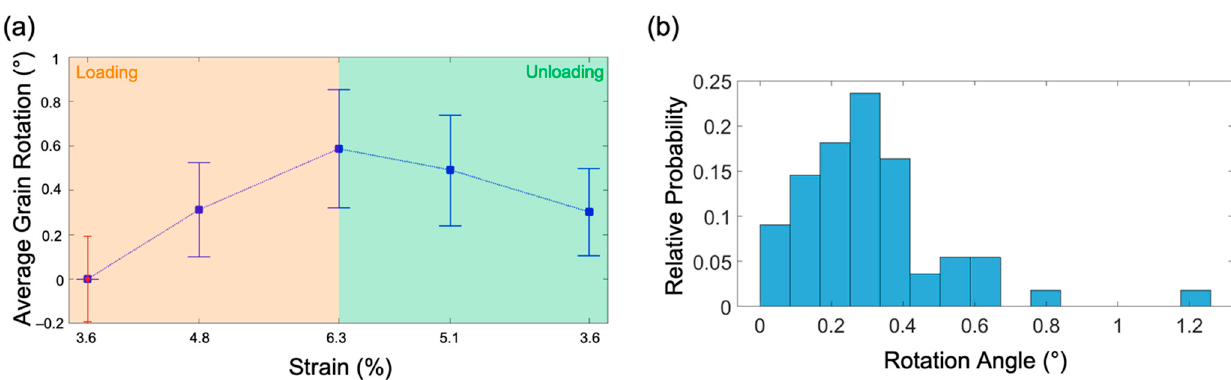
Figure 5. ( a ) Average grain rotation analyzed for 55 grains at different strain levels. The red error bar at 3.6% strain indicates the average of the standard deviation of the orientation variation in each individual grain, including variations due to curvature within the grain and small angle boundaries. The blue error bars indicate the standard deviation of the mean rotation angles at each deformation step. ( b ) Statistical analysis of the distribution of the rotation angles of grains during straining from 3.6% to 6.3%.